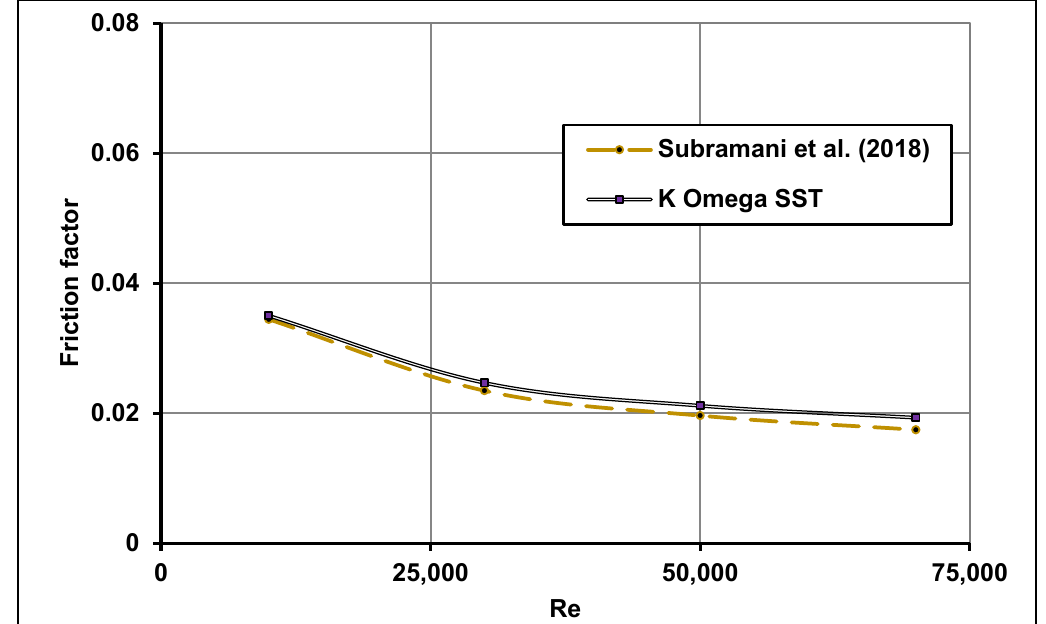
Figure 12. Computed friction factor comparisons with measurements of Subramani et al., [75].